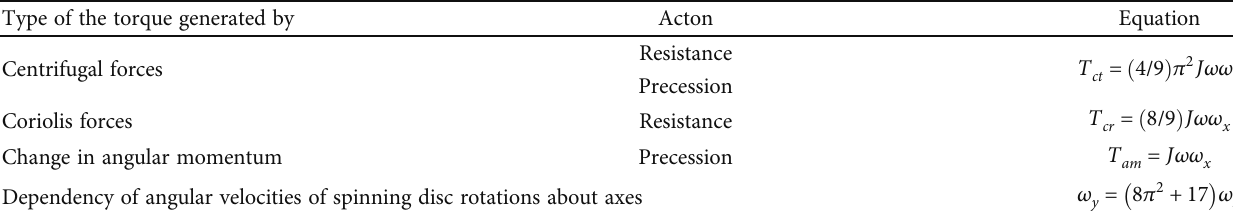
Table 1: Equations of the inertial torques acting on the spinning disc. Type of the torque generated